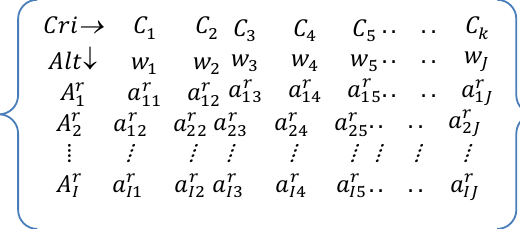
Table 8. Decision Matrix (Factor Comparison between elements) Expert:1 Prognosis & comorbidity Response to Treatment Age Depend. Responsibility